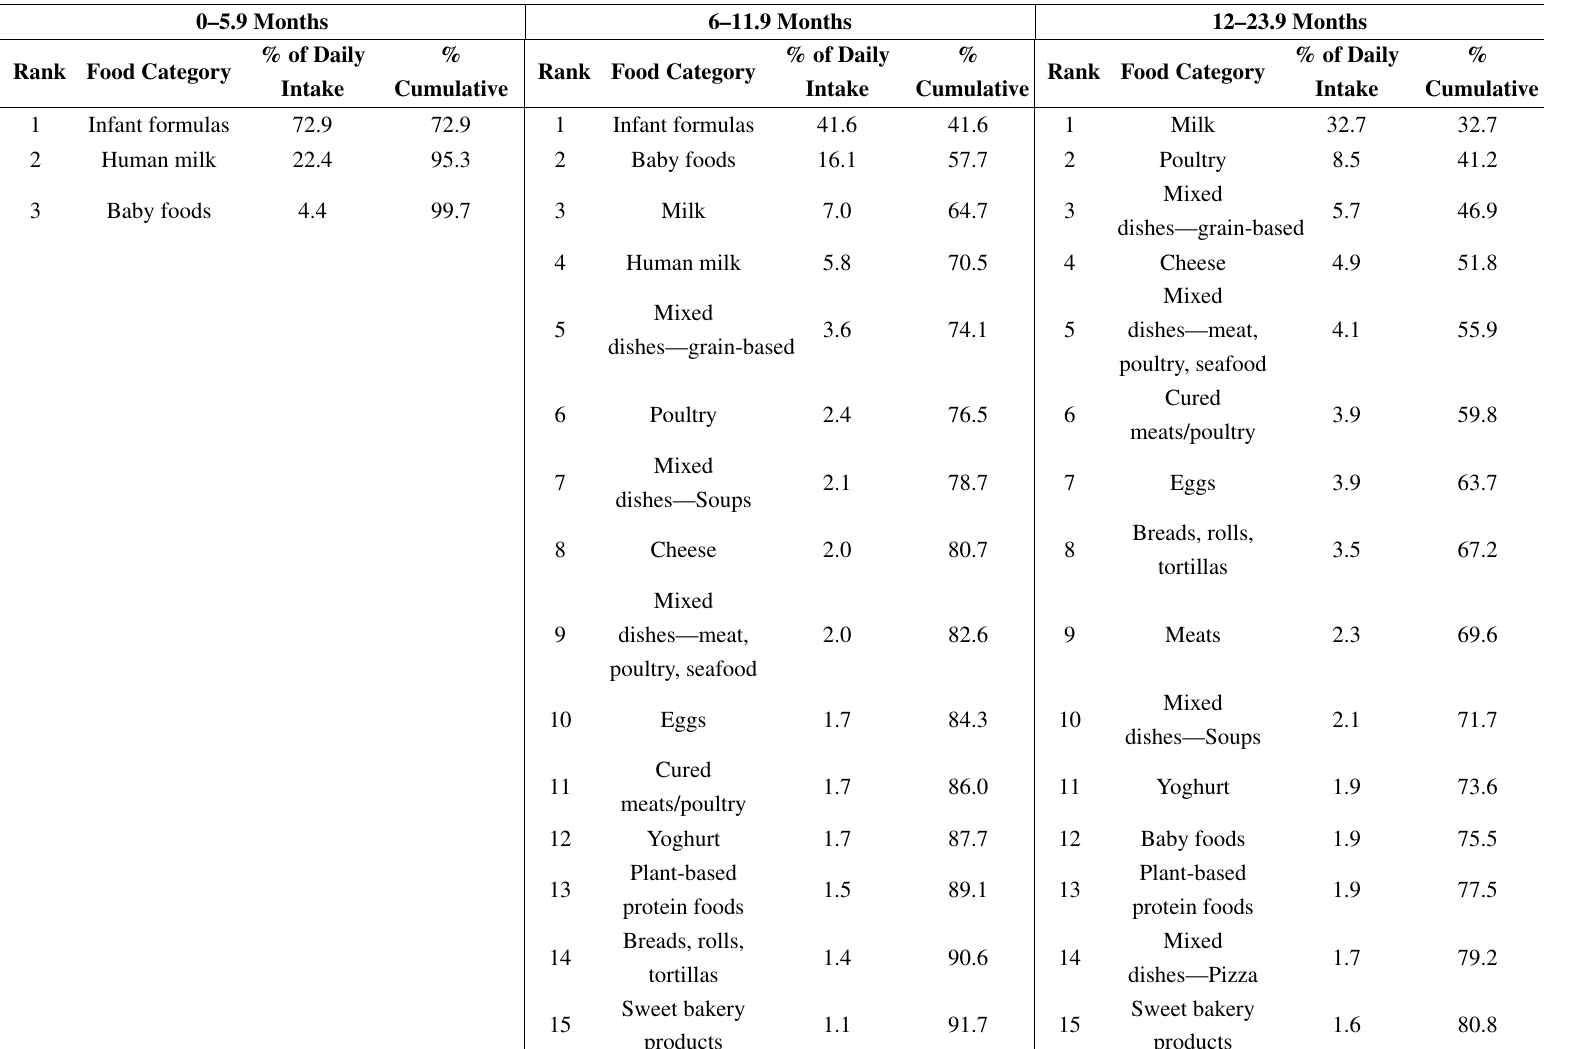
Table 3. Food sources of protein among US infants and toddlers aged 0–23.9 months by age group: NHANES 2005–2012 ( n = 2740) a